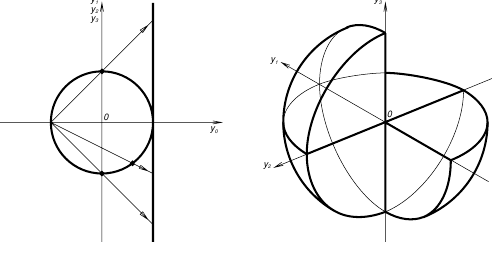
Figure 3. Stereographic projection and its image of Ω ++ ∩ S